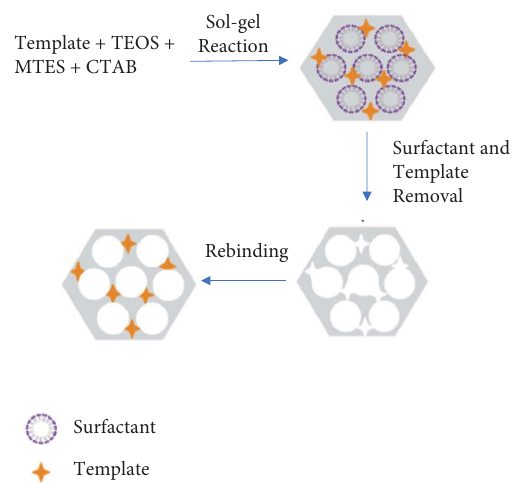
Figure 1: Te general synthesis method of molecularly imprinting polymer mesoporous silica